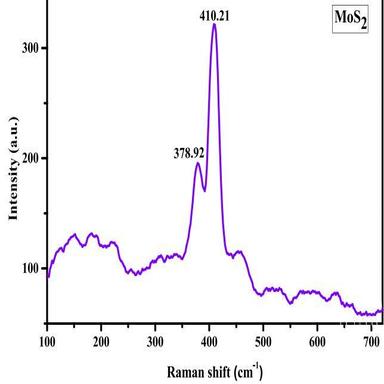
CV curves of MoS2 film at different scan rates.